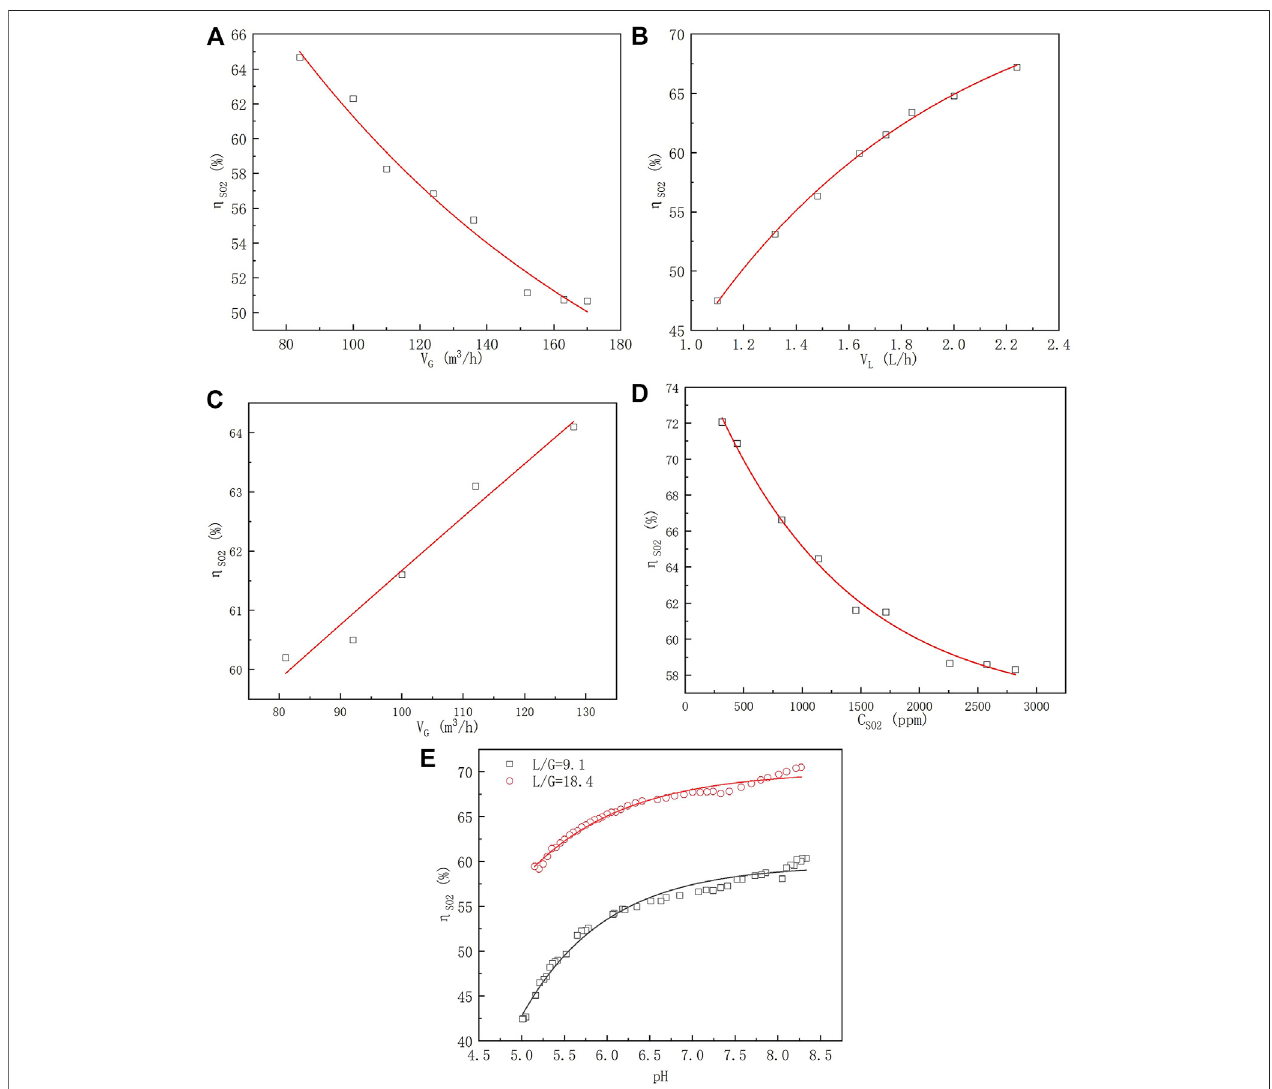
FIGURE3| RelationshipbetweentheSO 2 removalef fi ciencyofthesprayscrubberand (A) gas fl owrate(V L =1.62 m 3 /h,C SO2 =900±50 mg/m 3 ,andpH=6), (B) slurry fl ow rate (V G = 112 m 3 /h, C SO2 = 900 ± 50 mg/m 3 , and pH = 6), (C) gas fl ow rate operated under the same L/G (L/G = 16, C SO2 = 900 ± 50 mg/m 3 , and pH = 6), and (D) inlet SO 2